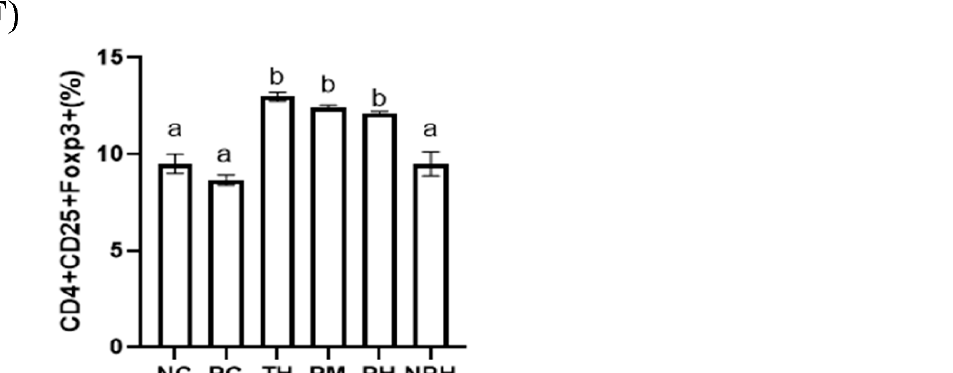
Figure 3. Differentiation levels of Th1 cells ( A , B ), Th2 cells ( C , D ) and Treg cells ( E , F ) in the spleen of Balb/c mice. NC corresponds to normal saline negative control group; PC corresponds to β-lactoglobulin positive control group; TH corresponds to trypsin hydrolysate group; PM corresponds to protamex hydrolysate group; PH corresponds to papain hydrolysate group; NPH corresponds to neutrase protease hydrolysate group. Data are shown as the mean ± SEM (n = 10) and different letters (a~d in ( B ); a~e in ( D ); a~b in ( F )) represent significant differences ( p < 0.05).